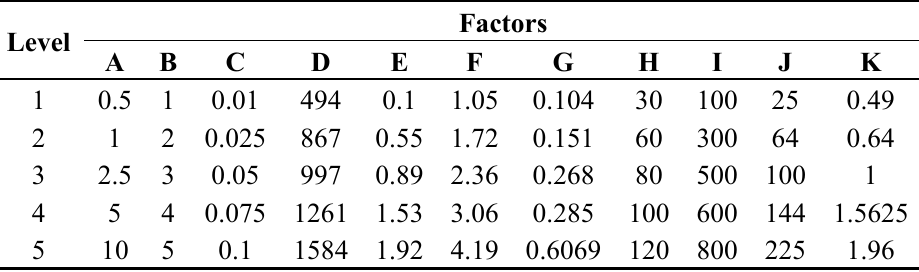
Table 2. Factors and levels used in the orthogonal array (OA) L 50 (design matrix).